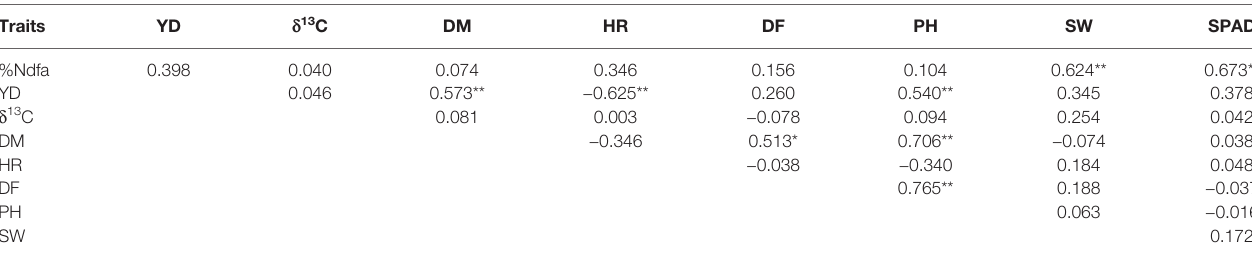
TABLE 8 | Correlations matrix identi fi ed among nine traits in 22 common bean genotypes evaluated at the Elora research station (ON) on N-poor soil in 2017 and 2018 using LSmeans data, N = 22. Traits YD d 13 C DM HR